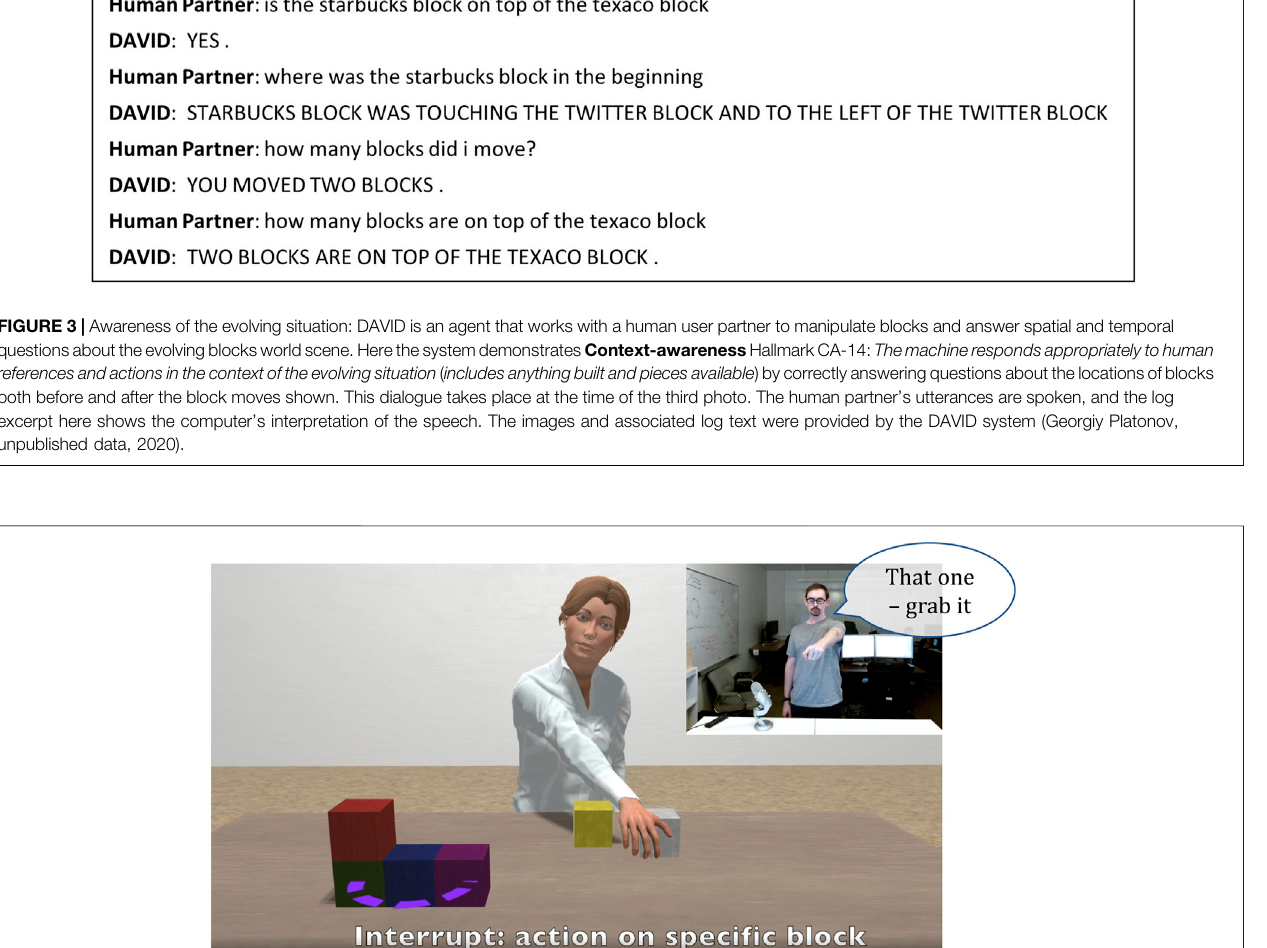
FIGURE 4 | Multi-modal interaction with asynchrony: As Diana reaches for the white block, the human partner interrupts her by pointing to the blueone and asking her to grab it instead. (The human is pointing from his perspective at the place on the virtual table indicated by the purple outline.) As described in the text, this example demonstrates Hallmarks RO-9, CA-6, MC-2, HE-1, and HE-2. The image was provided by the Brandeis Diana team (Krishnaswamy and Pustejovsky, email to the authors, February 5,